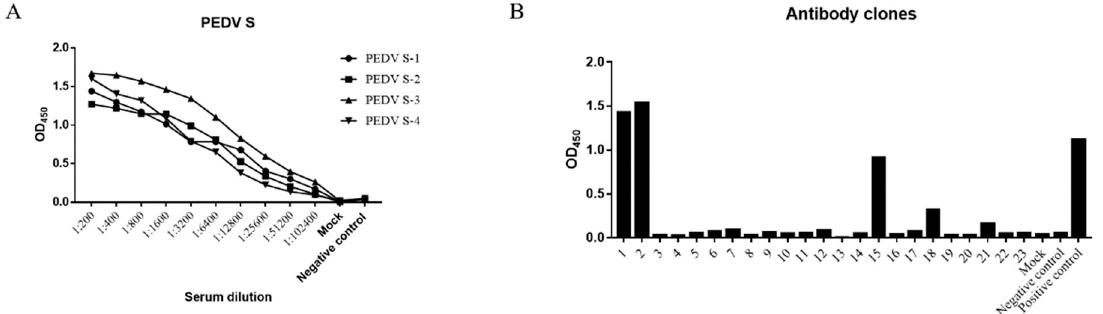
Figure 3. Measurement of anti-PEDV mAb-2. ( A ) Enzyme-linked immunosorbent assay (ELISA) measurement of serum IgG titers of the four immunized mice. ( B ) ELISA measurement of IgG in the supernatants of 23 hybridoma clones, the serum of mouse-3 was used as a positive control. The numbers of positive hybridoma cells were 1, 2, 15, 18 and 21. Their ODs450 were 1.462, 1.532, 0.914, 0.326 and 0.162 respectively.